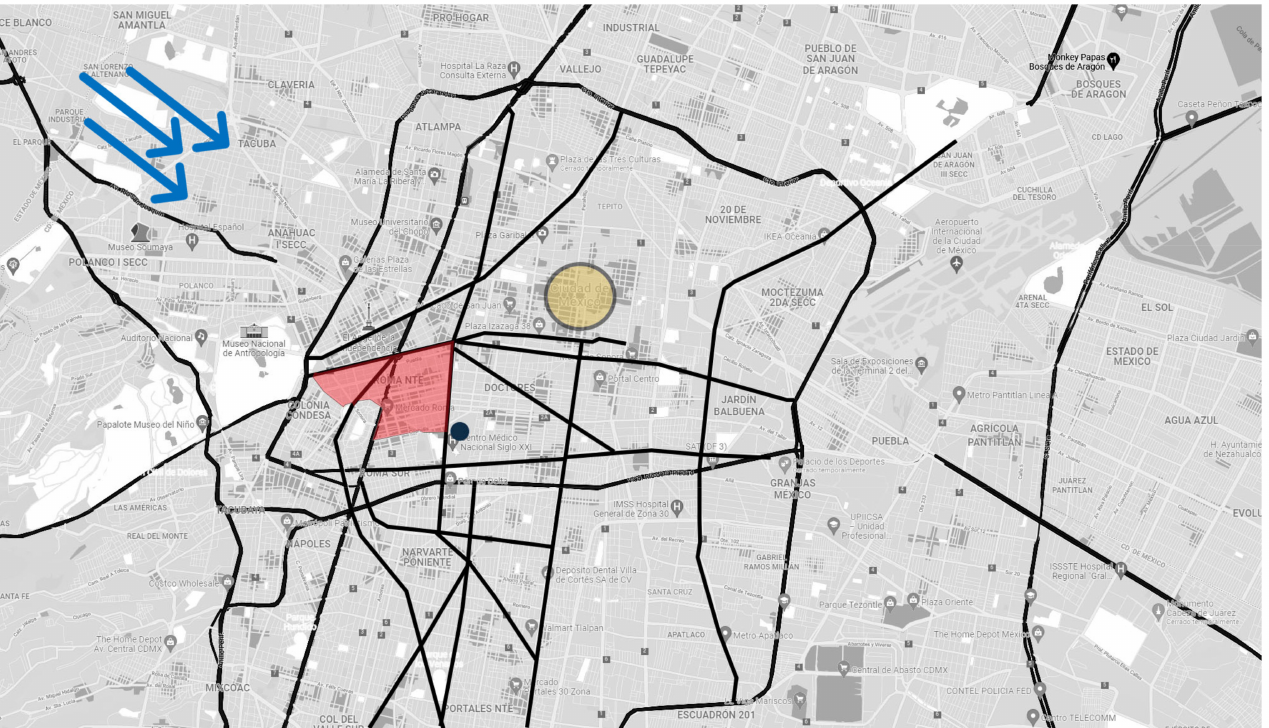
Figure 1. Location of the homes in Mexico City. The red highlighted area shows the Roma Norte. The navy dot represents the location of the monitoring station. The yellow circle highlights the area of the city centre. The blue arrows the main wind direction. Source: Authors, based on Google map